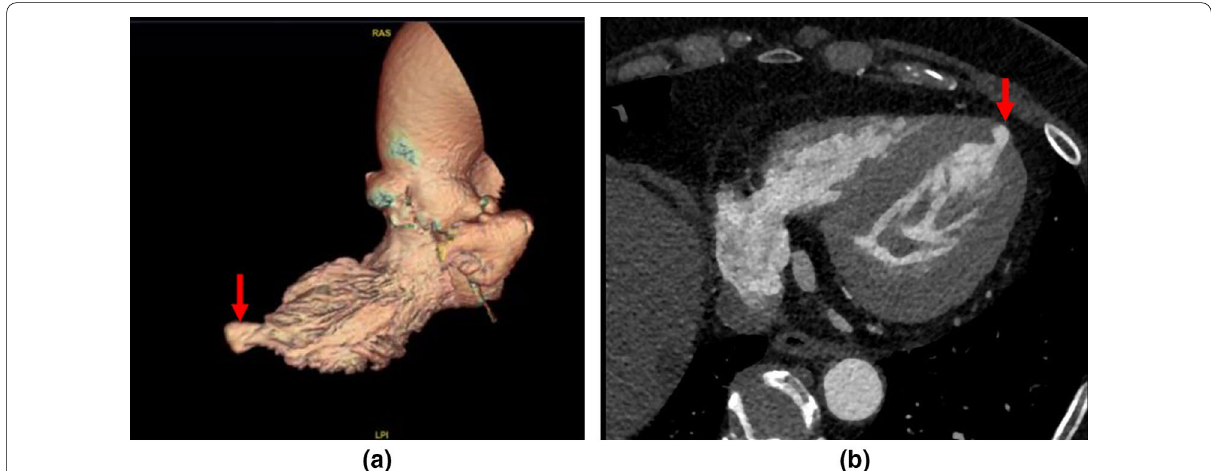
Fig. 2 A Computed tomography of the heart (preoperative) of Case 1 aneurysm of the apex of the heart (arrow). B Computed tomography of the heart (preoperative) of Case 2 aneurysm of the apex of the heart